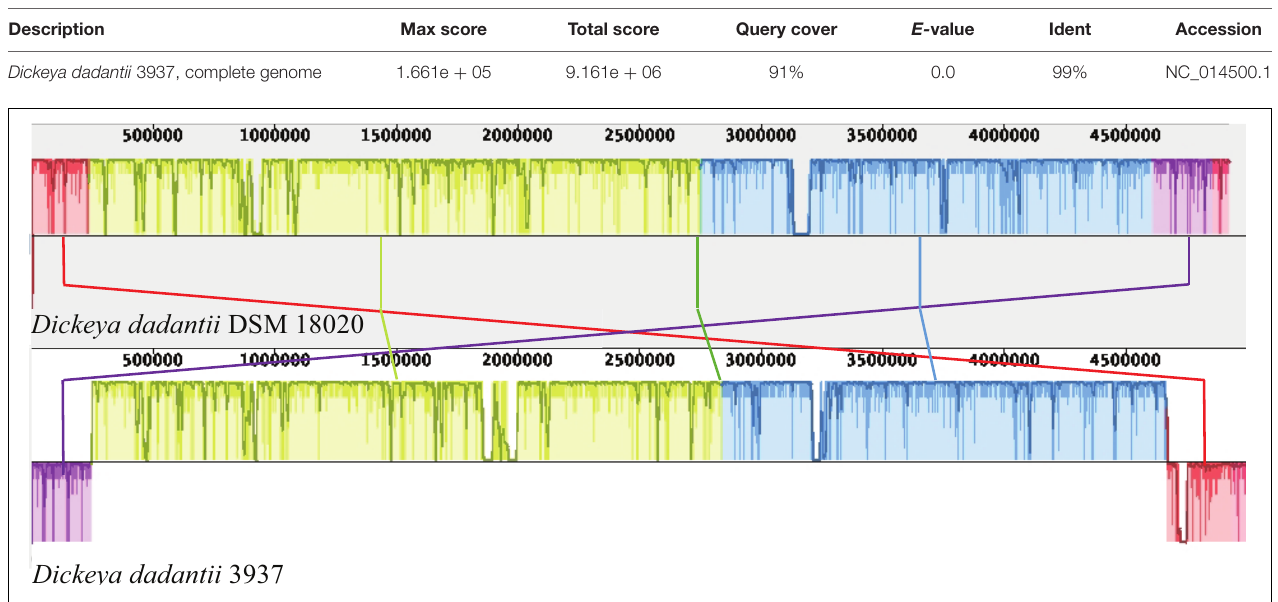
FIGURE 2 | Synteny analysis of Dickeya dadantii DSM 18020 (NZ_CP023467.1) and 3937 (NC_014500.1). Synteny analysis was performed using MAUVE whole genome alignment. Arrows indicate the regions that are located in different positions in both genomes.